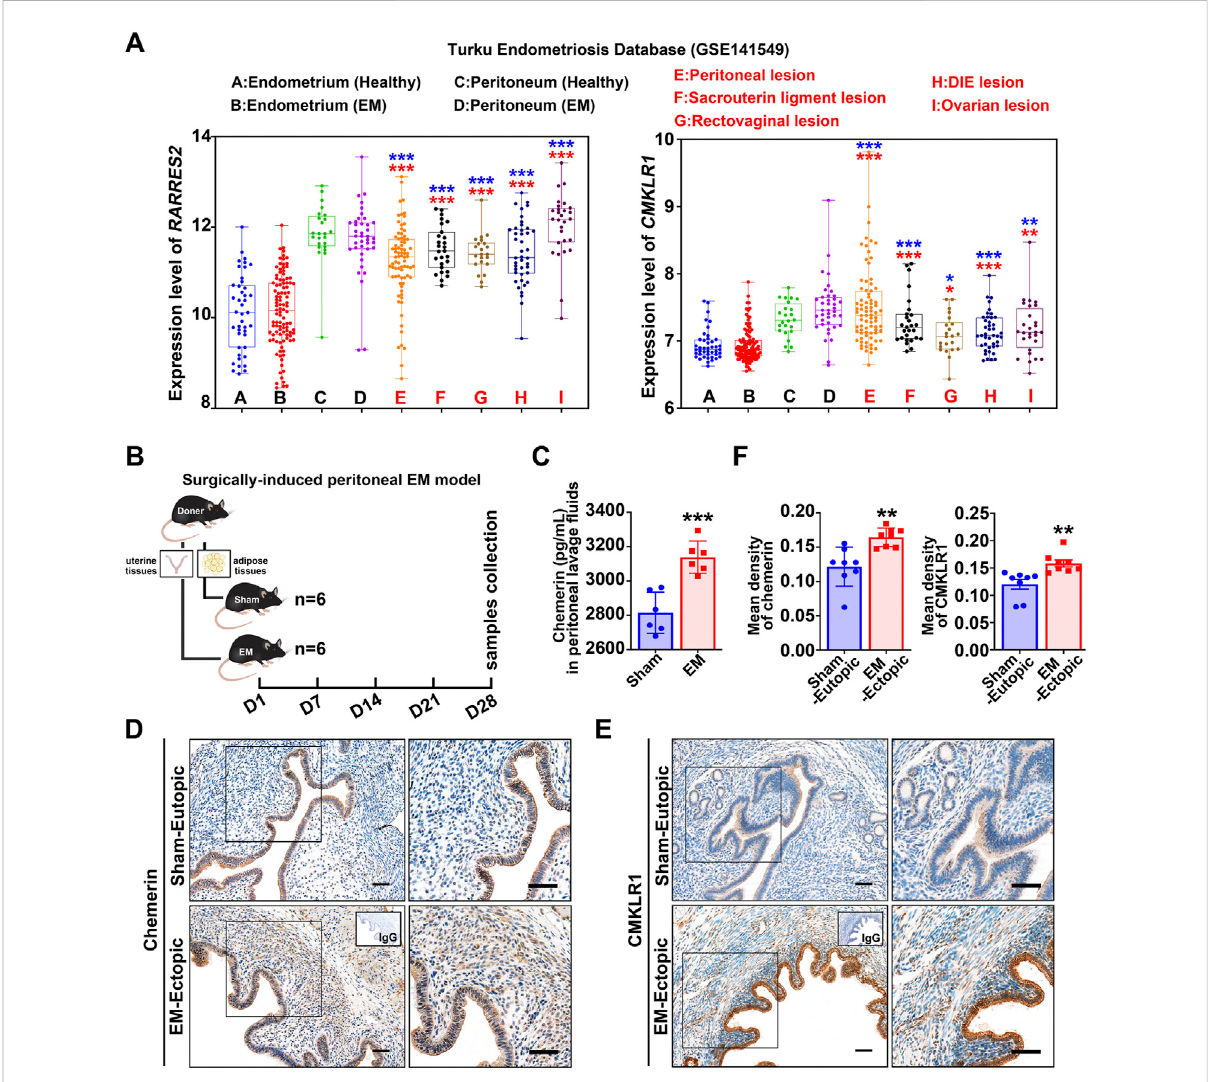
FIGURE 1 Chemerin and CMKLR1 are up-regulated in endometriosis. (A) Chemerin and CMKLR1 transcript levels in the endometrium, peritoneum, and endometriotic lesions from Turku endometriosis database (GSE141549). ns, not signi fi cant; blue, versus healthy endometrium; red, versus endometriosis endometrium; (B) Schematic of animal experimental-1 to analyze the chemerin expression in a surgically-induced peritoneal EM mousemodel. (C) Aftersurgeriesfor1month,chemerinlevelsinperitoneallavage fl uidsfromsham-( n =6)andEM-mice( n